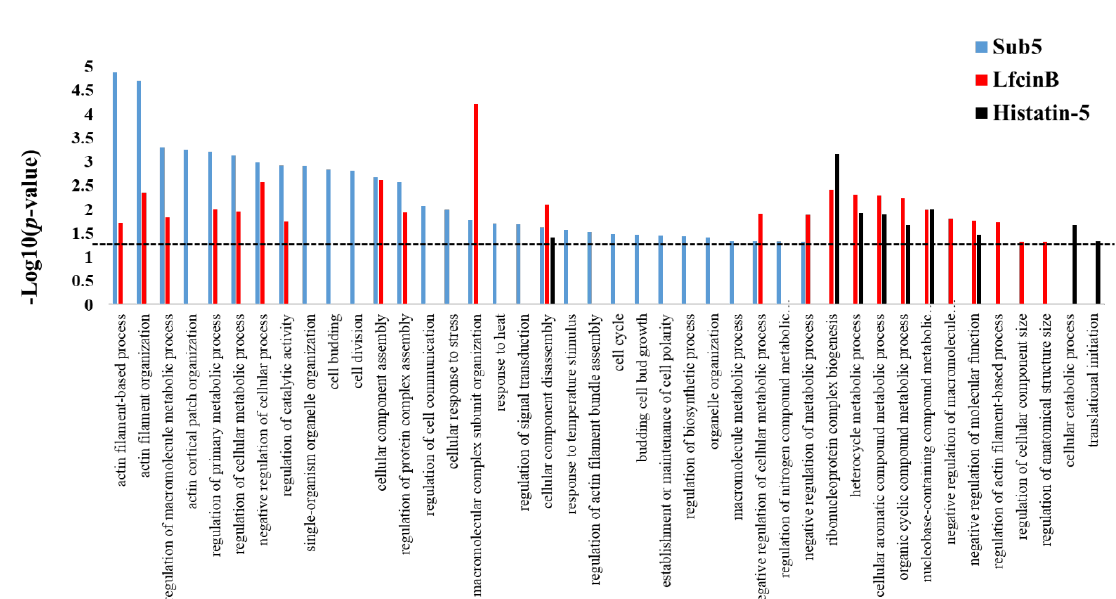
Figure 6. Comparison of the enriched categories in GO biological process for the protein targets of Sub5 (in this study) with Lfcin B and Histatin-5 (in previous study) identified by Saccharomyces cerevisiae proteome microarrays. AMPs have their unique sequence, structure, and functions. The enrichment result in the GO biological process of protein targets of Sub5 were compared with previously identified enrichment results in the GO biological process of protein targets of LfcinB and Histatin-5 to observe similarity and difference in the target patterns of AMPs. The p -value cutoff of 0.05 was indicated by dotted line.